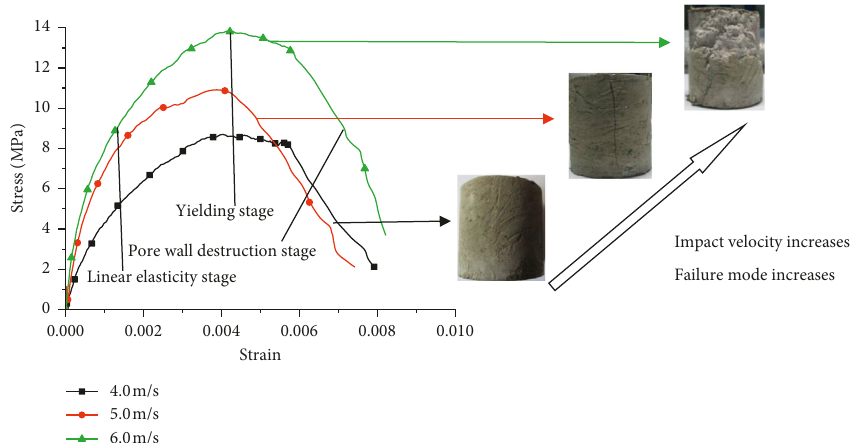
Figure 10: Foam concrete with sand stress-strain curve at 1,400kg/m 3 .